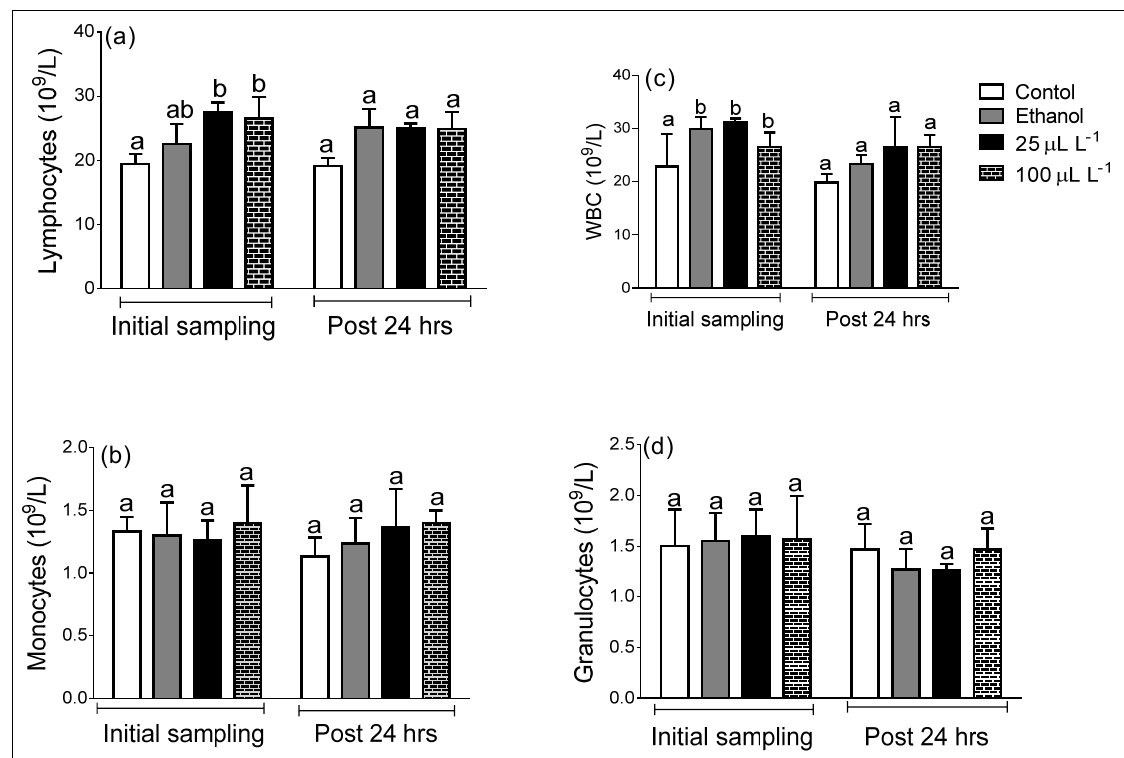
Figure 5. Lymphocytes ( a ), monocytes ( b ), WBC ( c ), and granulocytes ( d ) of Mozambique tilapia ( Oreochromis mossambicus ) subjected to two oregano concentrations (25 and 100 µ L L − 1 ), ethanol, and a control (water only), respectively. These parameters were sampled at 0 h and after 24 h. Values are given as mean ± standard error ( N = 3), and different lowercase letters indicate significant differences between treatment groups within a sampling time (0 h or 24 h) using one-way ANOVA and Tukey’s multiple comparison test.